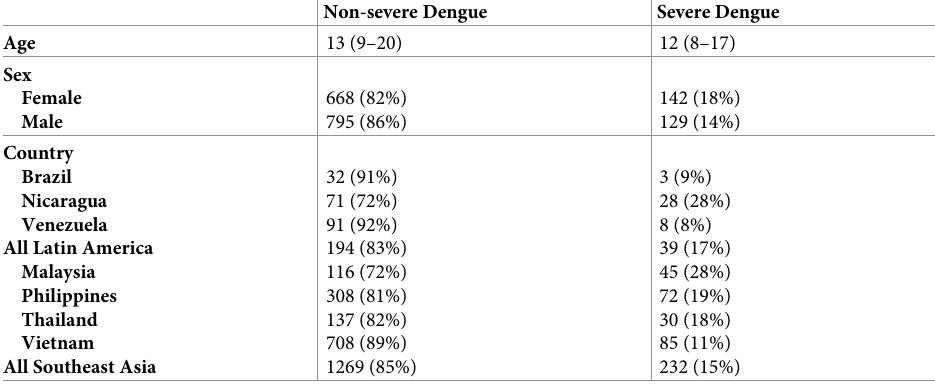
Table 1. Characteristics of study